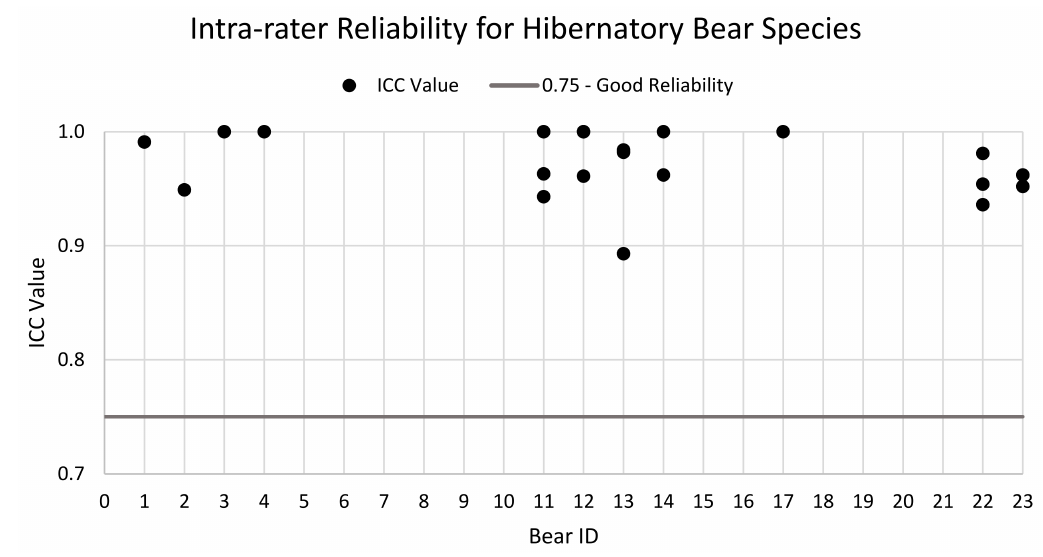
Figure 3. ICC values for all bears assessed for intra-rater reliability. The horizontal line sits at 0.75. Values above 0.75 are considered values of good reliability. In the case of bears with multiple assessments, the mean ICC score was calculated and depicted in the graph for each individual assessor. Table 3. Level of agreement between assessors for each bear assessed for intra-rater